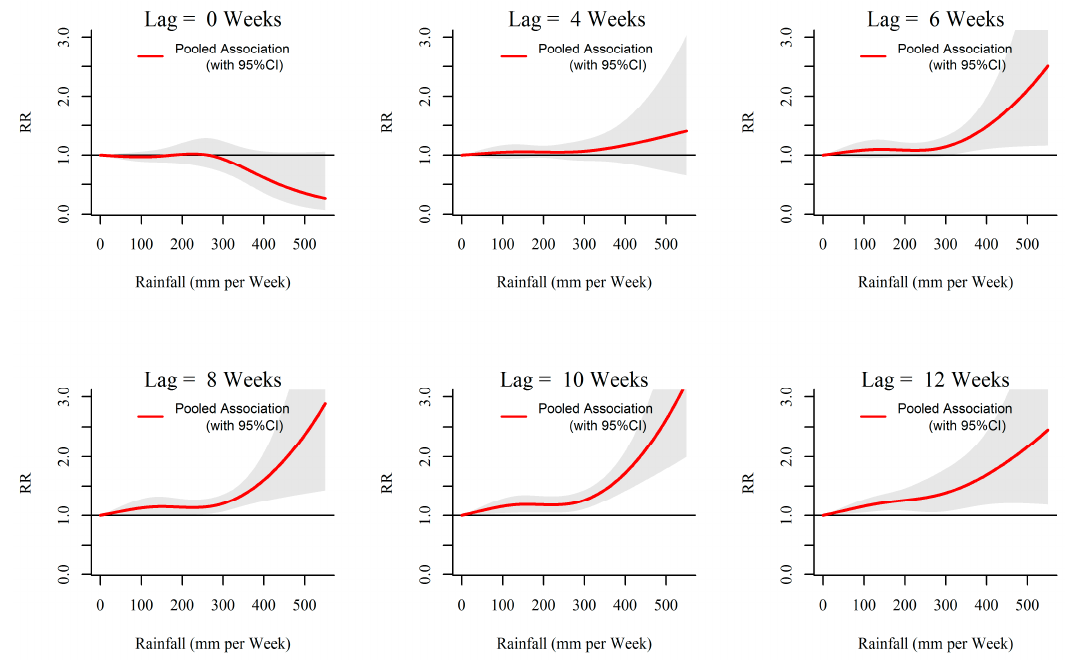
Figure 6. Relative risk (RR) of dengue by weekly cumulative rainfall at specific lags in 10 MOH divisions in Kalutara district, Sri Lanka, 2009–2013. The figure illustrates the predicted curves from meta-regression for different lag periods; 0, 4, 6, 8, 10 and 12 weeks. The shaded areas represent 95% confidence intervals. Reference at 0 mm per week.